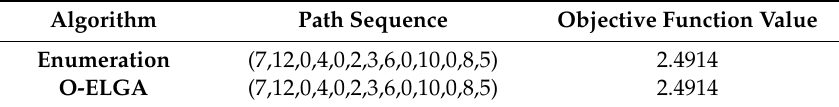
Table 2. The objective function values of the di ff erent